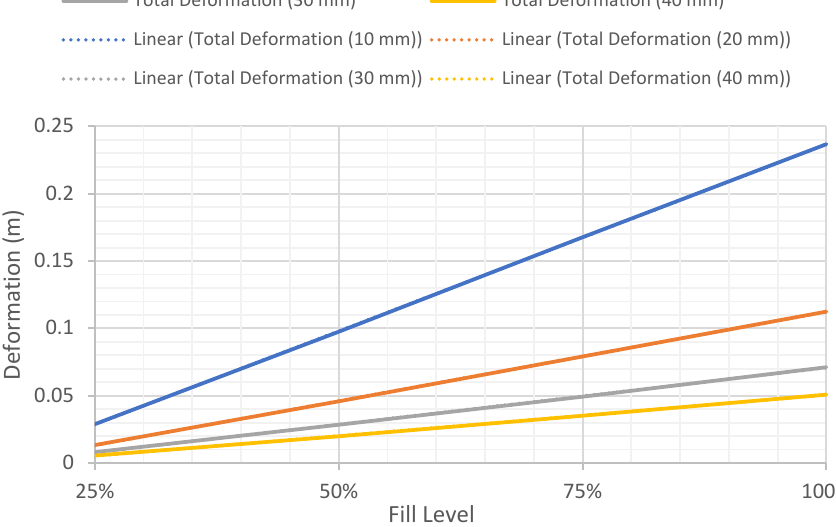
Figure 2. Variation of maximum total deformation of different wall thicknesses versus fill level.